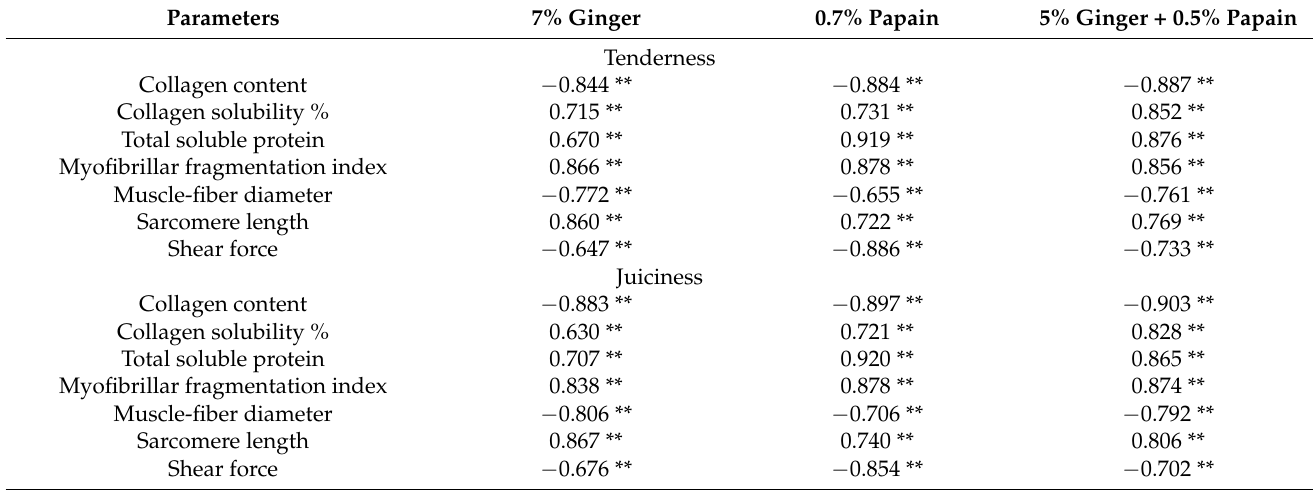
Table 3. Correlation matrix between some sensory attributes and other quality parameters of camel semitendinosus muscle tenderized with different